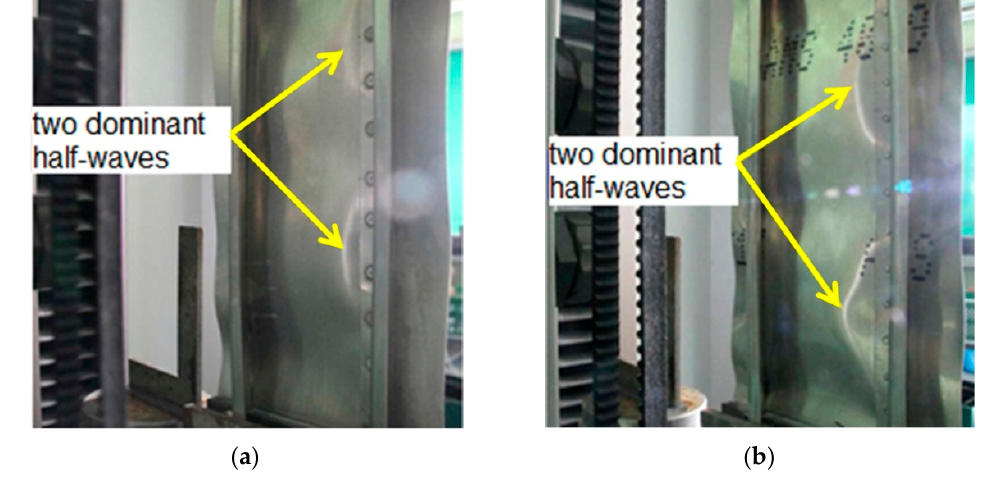
Figure 6. View of the postbuckling deformation of a panel subjected to a compression load of 4.2 × 10 3 N: ( a ) Welded variant, s = 29.5 mm; ( b ) riveted variant, s = 23.5 mm.